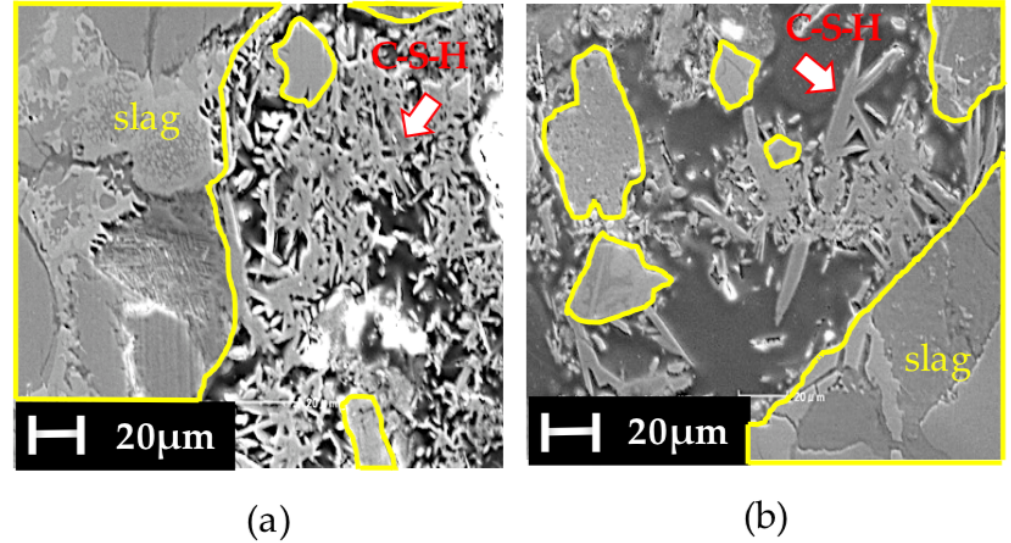
Figure 11. C-S-H observed by SEM analysis of: ( a ) mixture 1A and ( b ) mixture 1D, after 3 days of curing.